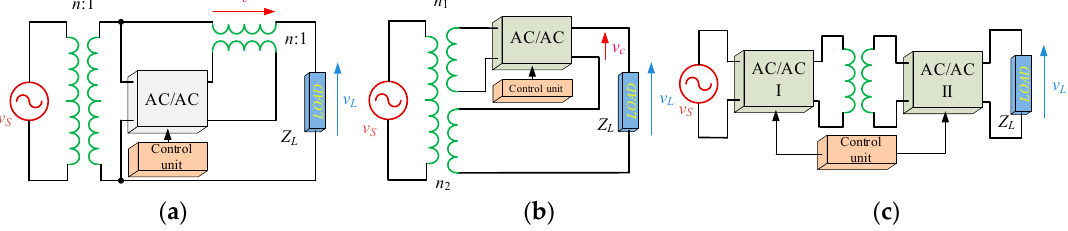
Figure 20. Single phase equivalent models of AC/AC converters installed in the power grid, ( a ), ( b ) high reliability configurations, ( c ) low reliability configuration.